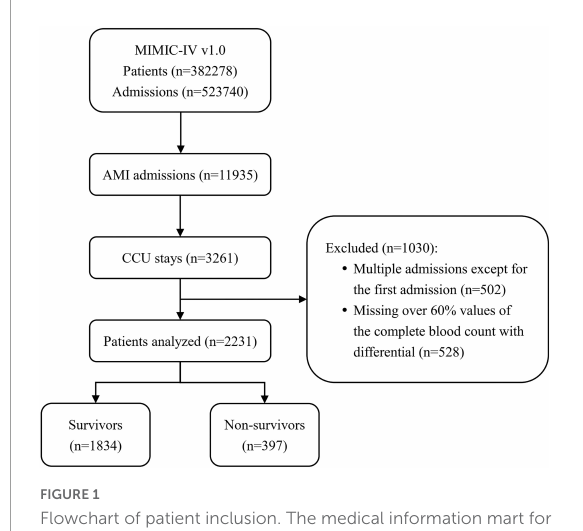
FIGURE1 Flowchart of patient inclusion. The medical information mart for intensive care IV (MIMIC-IV) (version 1.0) database includes medical records of 5,23,740 admissions from 3,82,278 patients. In total, 11,935 admissions had a discharge diagnosis of acute myocardial infarction (AMI), of which 3,261 were admitted to the coronary care unit (CCU). After excluding 502 multiple admissions except for the first admission and 528 patients missing over 60% values of the complete blood count with differential (CBC w/diff) test, 2,231 patients were ultimately included in this study, of whom 397 died. MIMIC, medical information mart for intensive care; AMI, acute myocardial infarction; CCU, coronary care unit; CBC w/diff, complete blood count with differential.